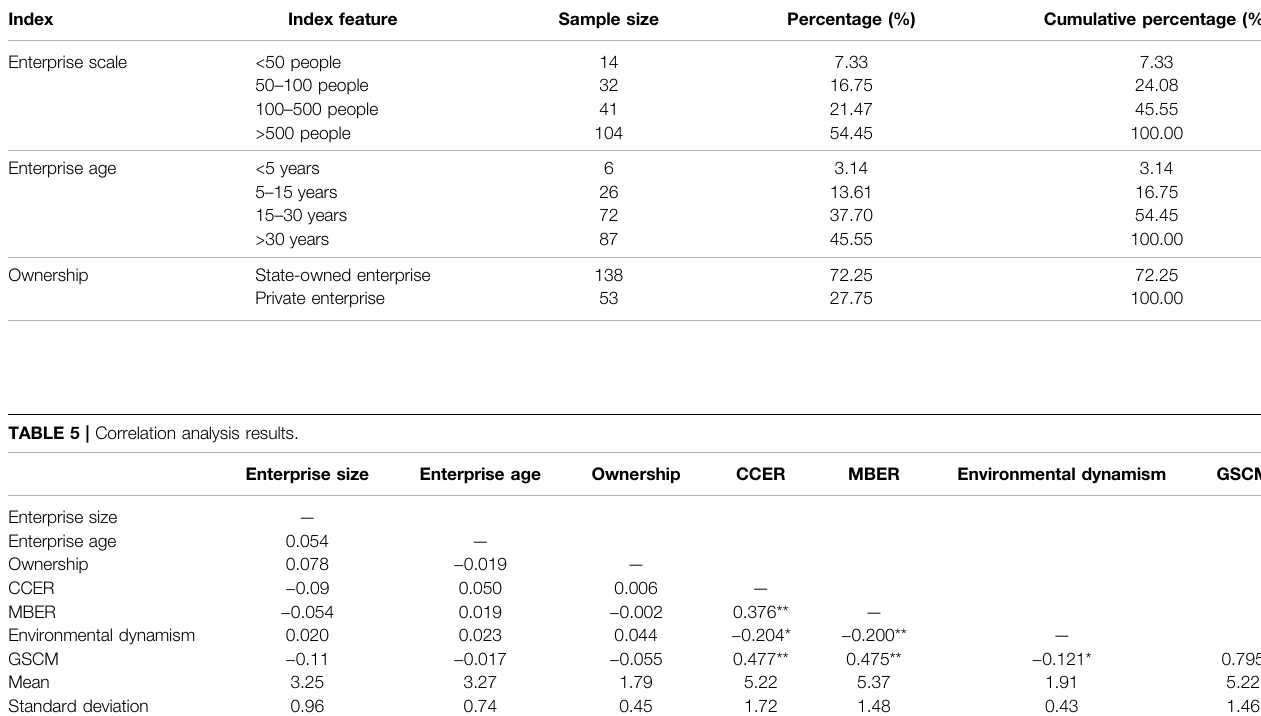
TABLE 4 | Sample descriptions.